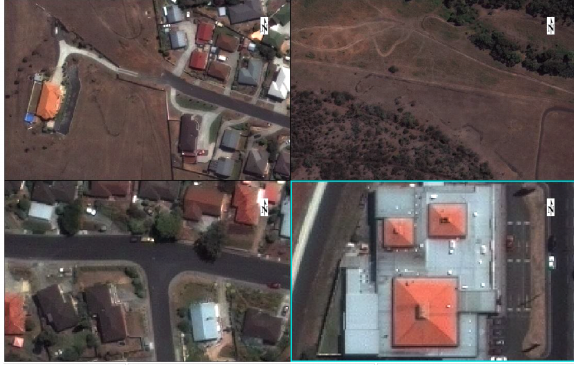
are presented in figure 10.